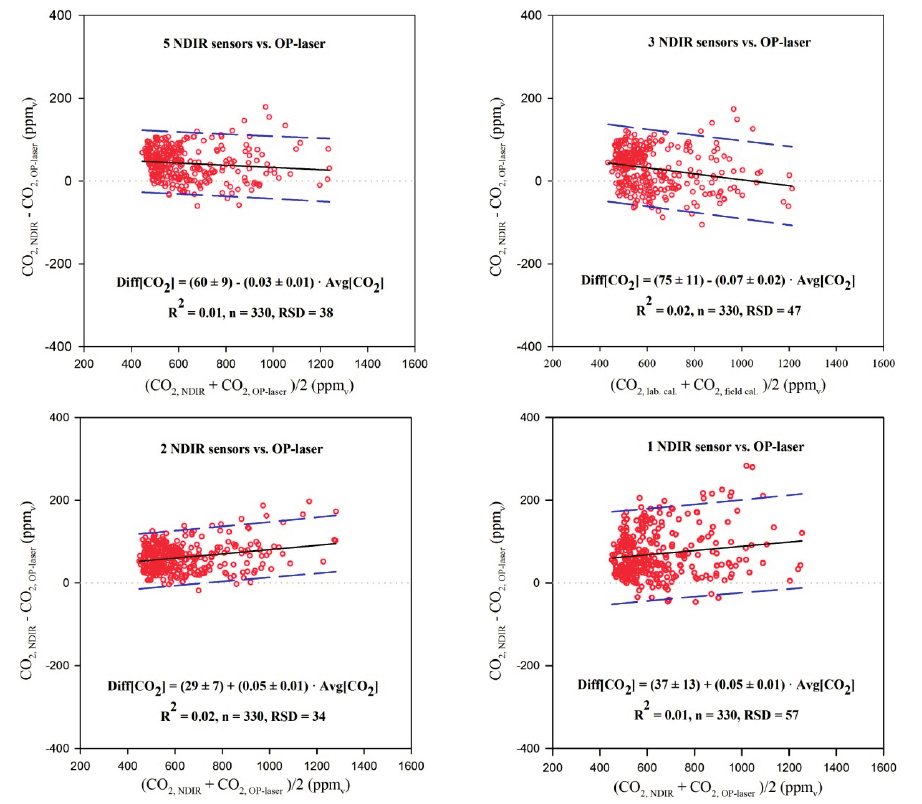
Figure 8. Bland-Altman charts for the comparison of CO 2 concentrations measured with the NDIR sensors and the OP-laser, averaging out data from different numbers of NDIR sensors. The dashed blue lines represent the 95% confidence